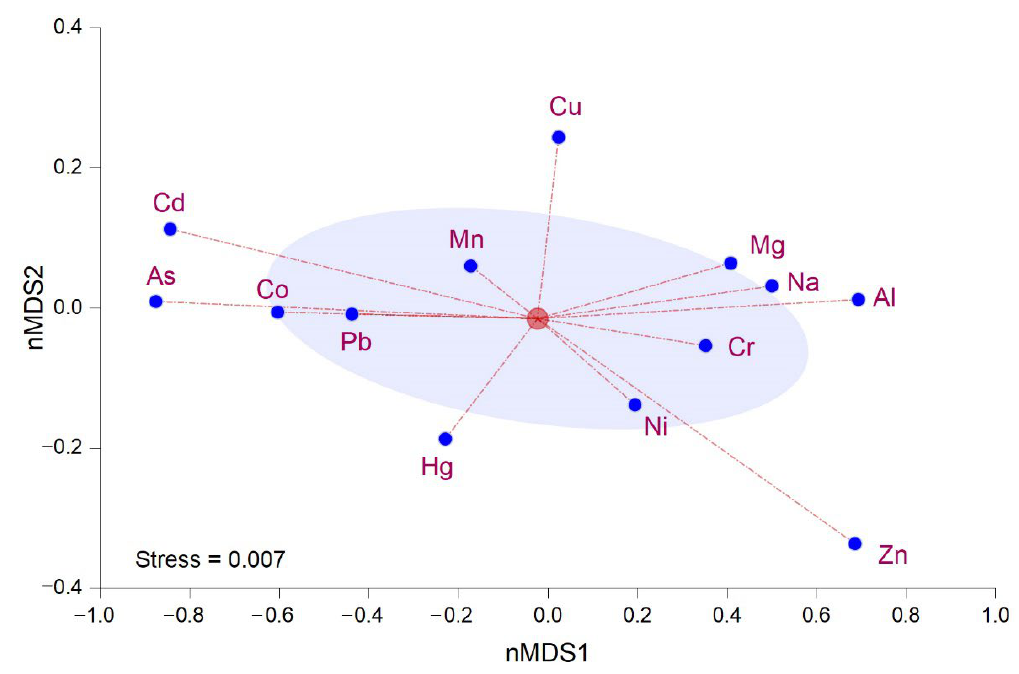
Figure 6. Non-metric dimensional analysis of heavy metals in plant essential oil products.